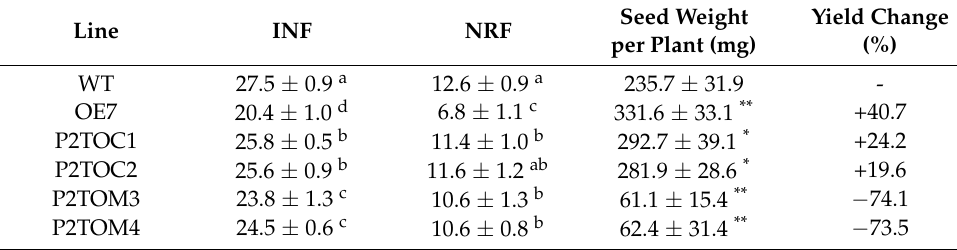
Table 1. Flowering times and seed yields of WT and various OE lines under long-day regime. Line INF NRF